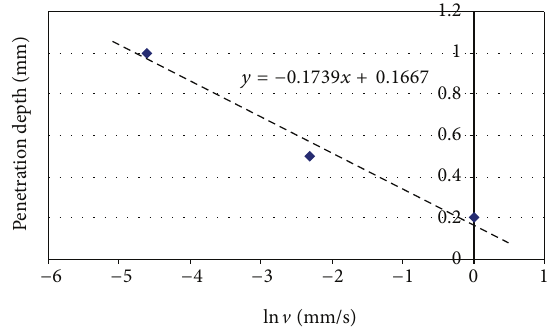
Figure 3: Penetration depth as a function of cutting